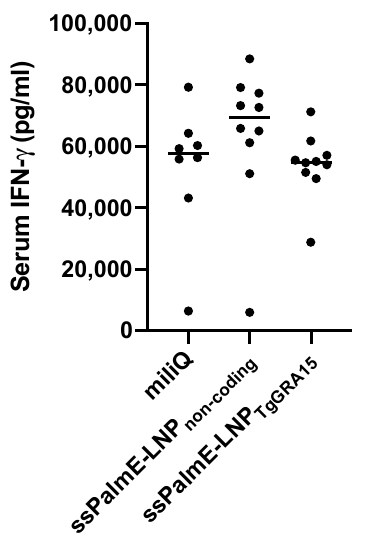
Figure 3. Measurement of IFN- γ in serum of immunized mice at 7 days post infection. Sera from mice immunized with ssPalmE-LNP TgGRA15 ( n = 10), ssPalmE-LNP non-coding ( n = 10), or Milli-Q water ( n = 8) were analyzed using ELISA. The values are expressed as optical densities at 450 nm. The results were analyzing using one-way ANOVA and a Tukey–Kramer post hoc analysis, but there was no significant difference.